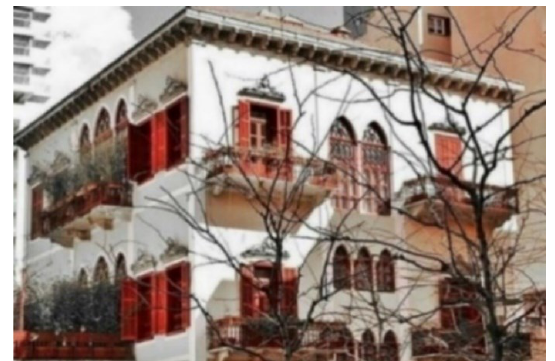
Figure 5. Photo of a traditional house in Saifi region, Beirut (photo by Ousama Sandid available at Beirut Heritage group, archived in 2017)